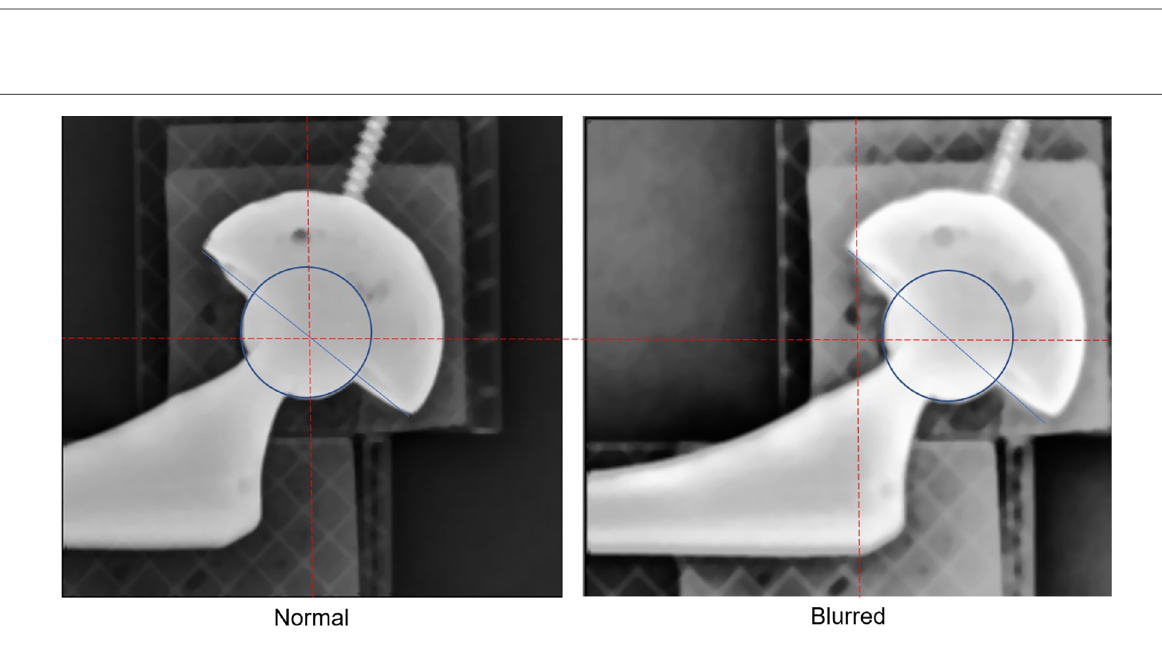
FIGURE 6 The blur of the edge detection area. For the same x-ray image, different speci fi cations of rectangular edge detection areas result in different image sharpness. The left one is normal, but the right one is blurred. In the normal case, the rectangular edge detection area is speci fi ed such that its center is at the very center of the femoral head. In the blurred case the rectangular edge detection area is speci fi ed so that its center is considerably off the center of the femoral head, causing the edge detection area to